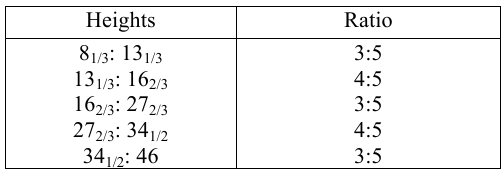
Table 5. Heights ratio